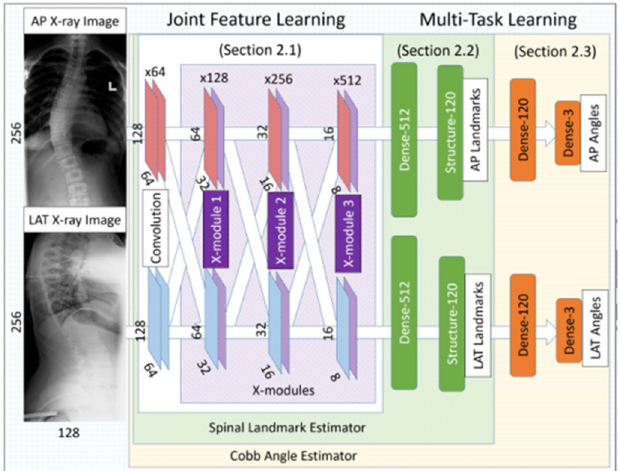
Figure 7. The structure of the MVC-net [67]. MVC-net consists of three parts: a convolutional layer for feature extraction (the convolutional layers are connected with X modules for feature joint learning); a spine landmark output layer and a Cobb angle output layer.